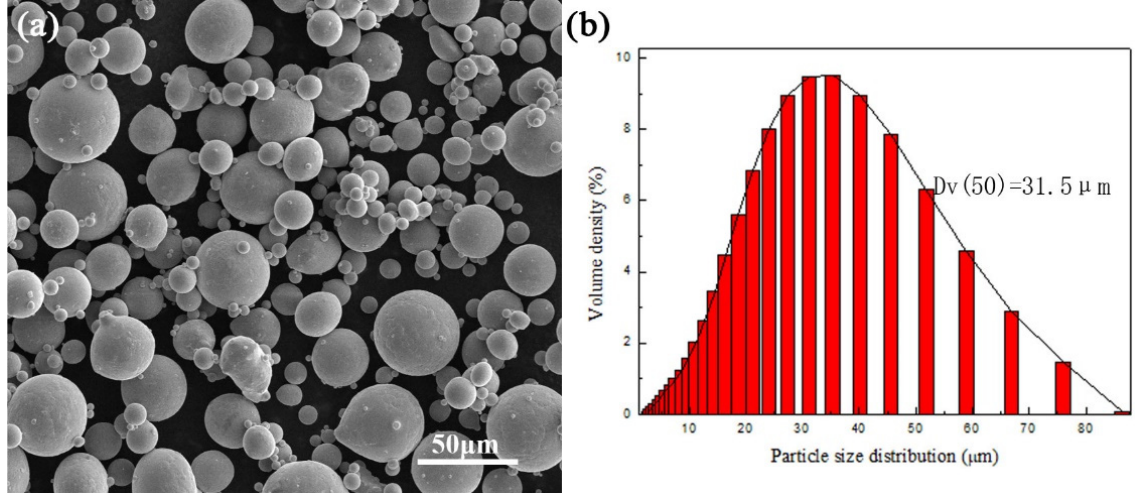
Figure 1. ( a ) Morphology and ( b ) the particles diameter distribution of the Ti-55511 powders.